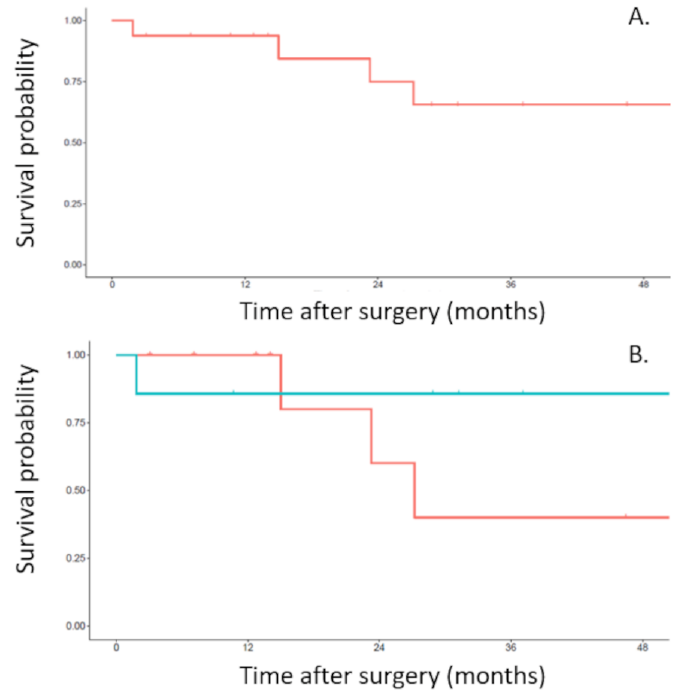
Figure 2. Overall survival from the date of en bloc resection of the upper lobe, chest wall and vertebra. ( A ). Overall survival of the whole population of the study. ( B ). Overall survival related to the one-step (red line) or two-step (blue line) approach.